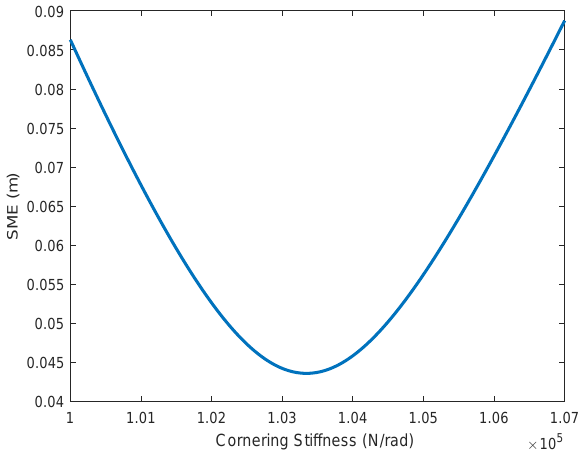
Figure 6. Square mean error between the dynamic model and CarSim data versus cornering